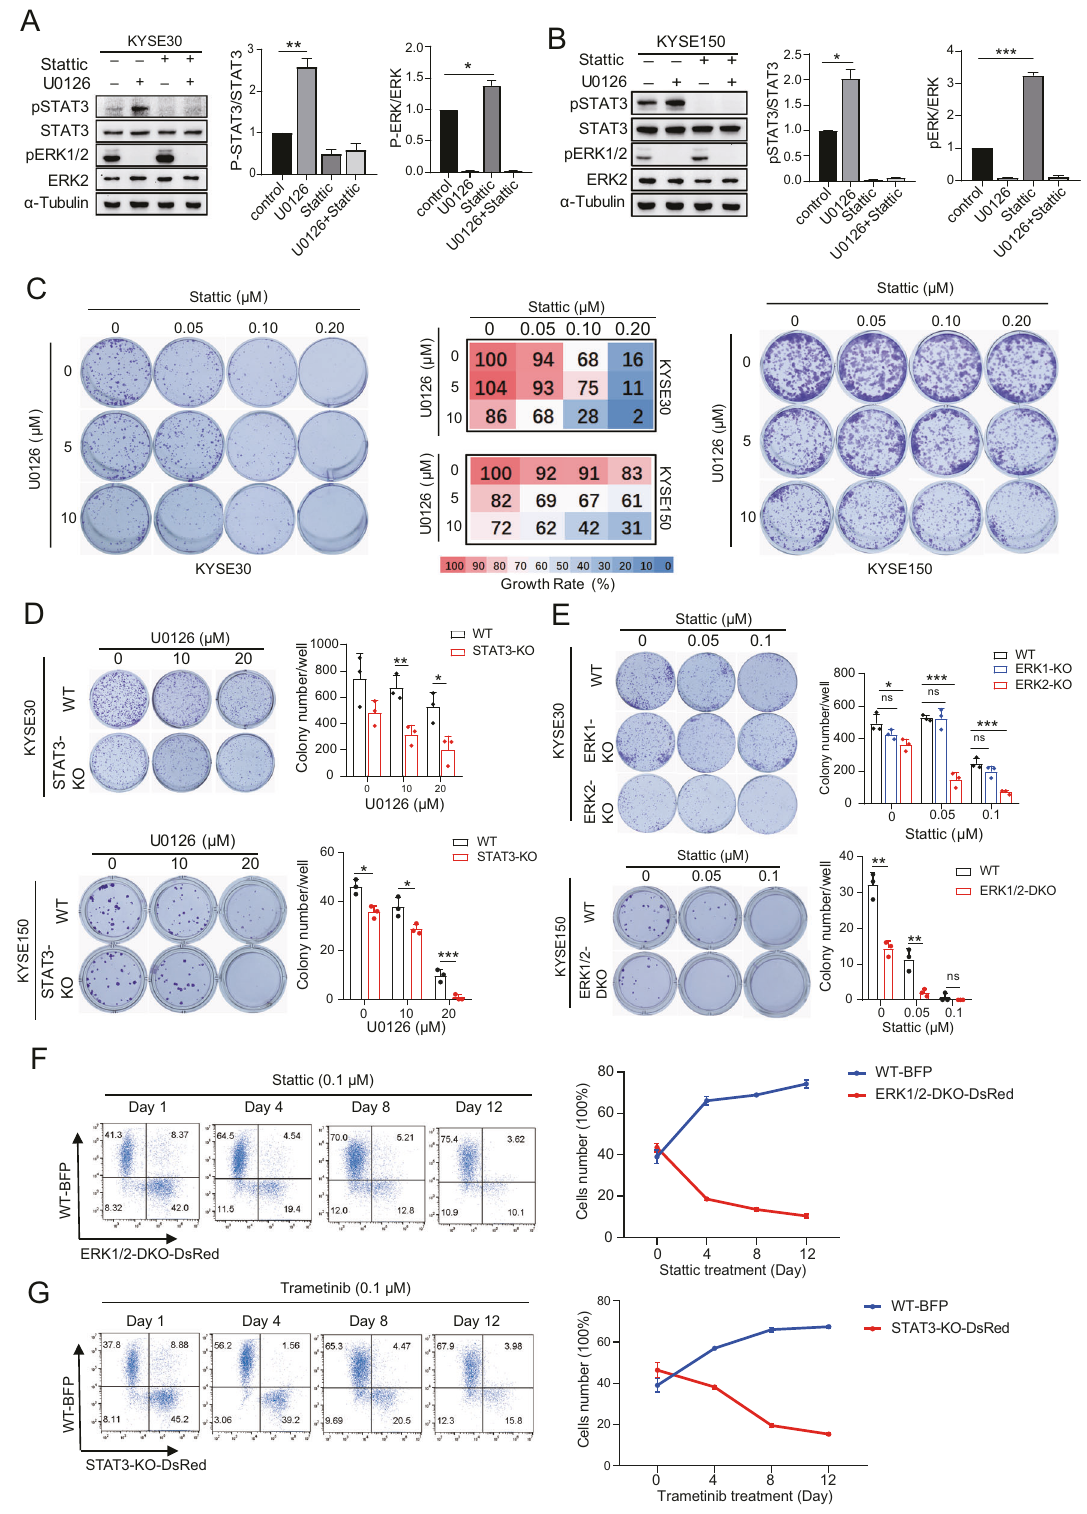
regions (Fig. 5D). To measure the regulatory effect of ELK1 on its target promoters, we performed a luciferase reporter assay with the SOCS3 promoter containing either a WT or mutant ELK1- binding motif (Fig. 5E). Induction of luciferase activity, by EGF treatment, was much greater when the luciferase reporter